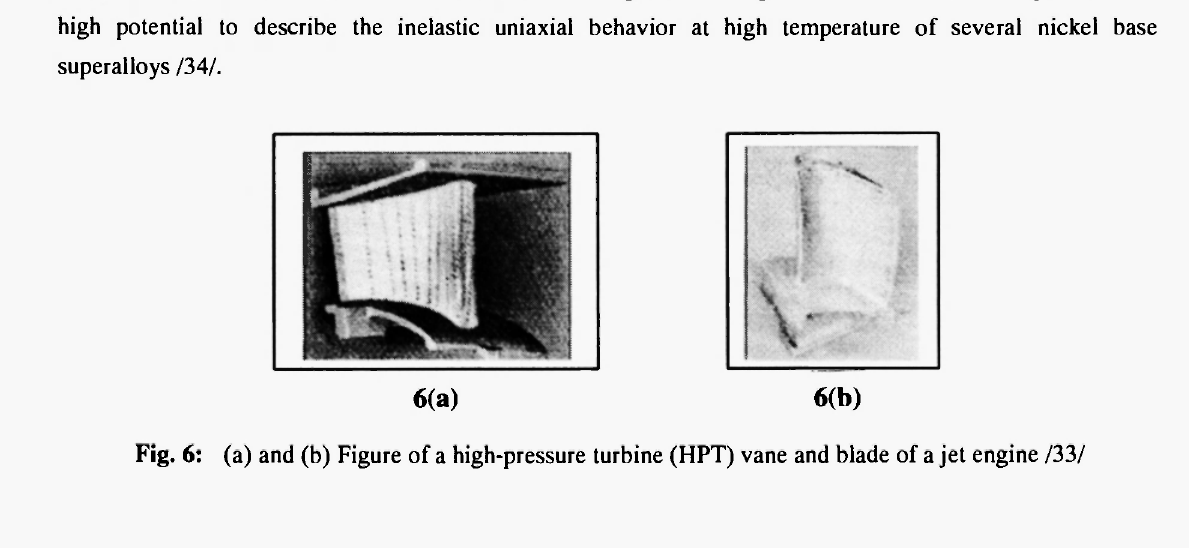
Fig. 6: (a) and (b) Figure of a high-pressure turbine (HPT) vane and blade of a jet engine